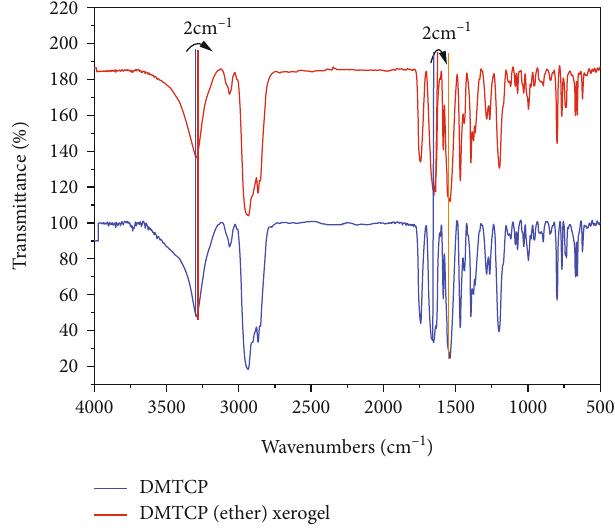
Figure 8: Infrared comparison between DMTCP (ether) xerogel and